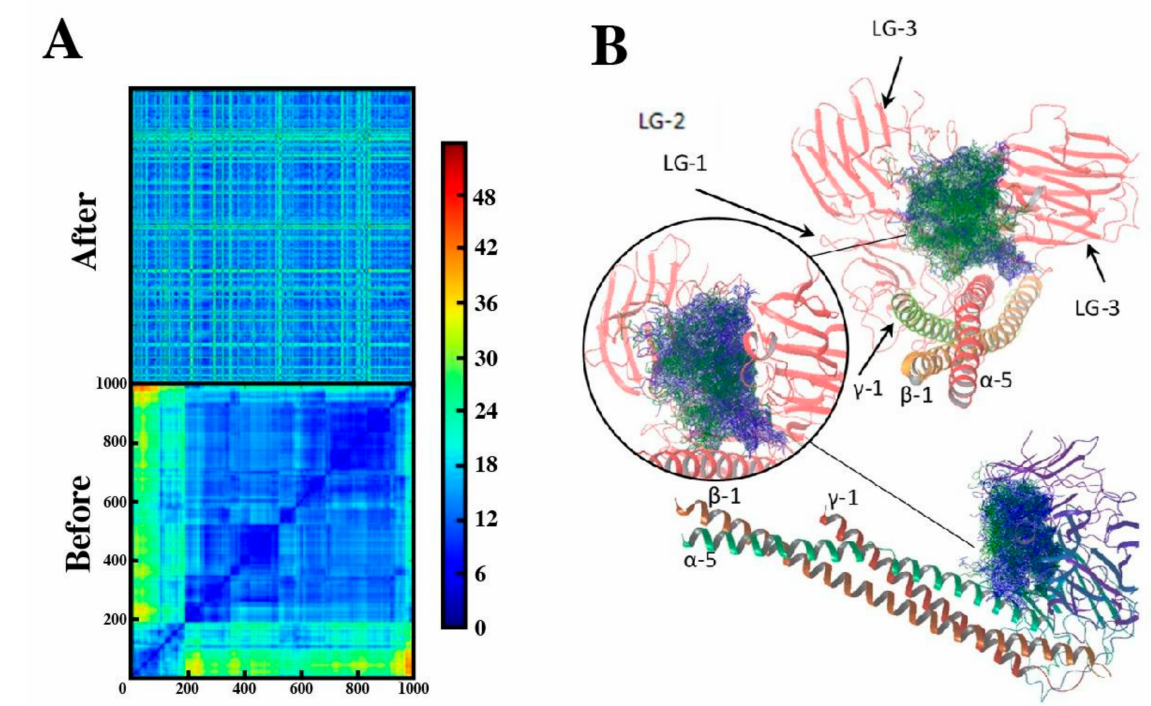
Figure 4. Clustering of peptide-88 poses performed by atomic RMSD comparison. ( A ) The symmetrical distance matrix illustrates atomic RMSD comparison of the 1000 poses of peptide-88 found by molecular docking. On the diagonal line, the RMSD is zero because the poses are compared with themselves. Matrix of peptide-88 poses organized before (top panel) and after (bottom panel) clustering process. The input order is kept on the diagonal; accordingly, the clusters are now visible as squares on the line. The sidebar represents the RMSD atomic distance scale in Å. ( B ). Significant clusters 16 and 20 are represented by blue and green lines,